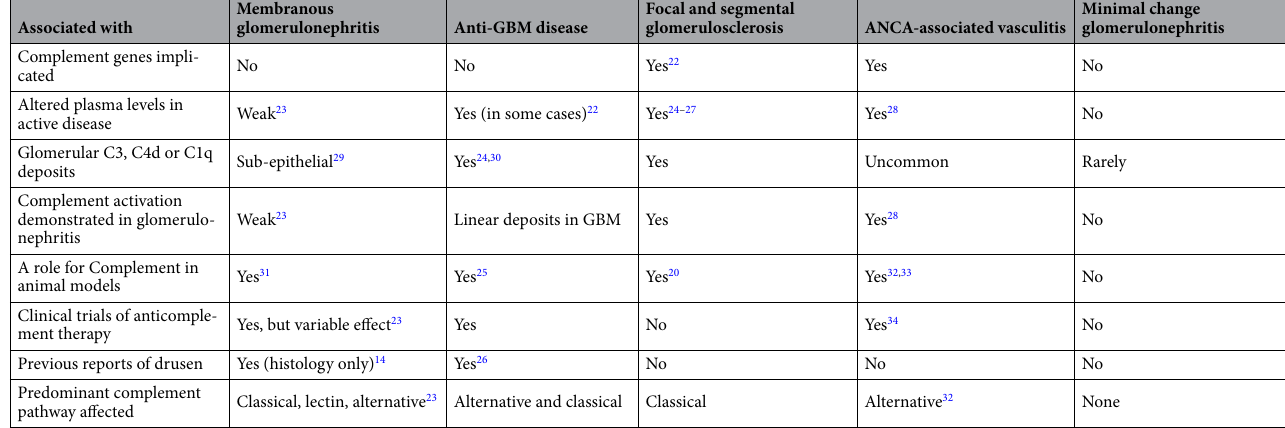
Table 1. Evidence for complement involvement in different forms of